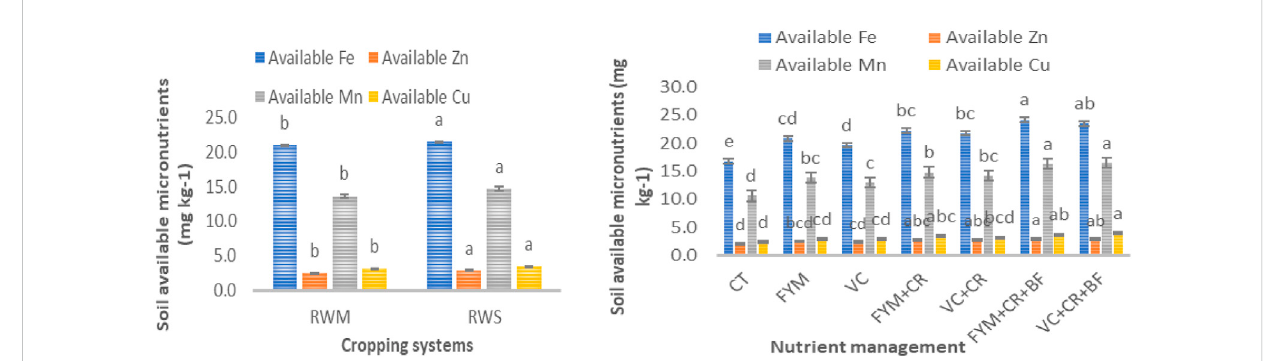
FIGURE 10 Long-term effect of cropping systems and organic nutrient management on soil available Fe, Zn, Mn, and Cu. RWM: rice-wheat-mung bean; RWS: rice-wheat-sesbania; CT: control; FYM: farm yard manure; VC: vermicompost; CR: crop residue(s); and BF: biofertilizer(s). Statistical method: analysis of variance for strip-plot design in SAS 9.3 software; n = 42. Values with a different capital letter indicate a signi fi cant difference among the different treatments at p < 0.05 by the LSD test. Bars represent means ± SEM.